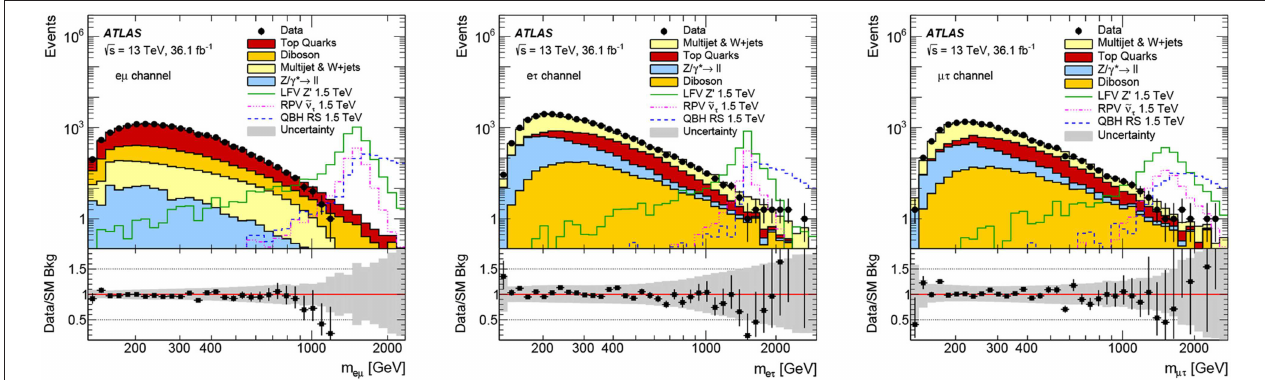
FIGURE 8 | The dilepton mass distributions of e µ without b -jet veto applied (left), e τ (middle), and µτ (right) pairs for data and SM predictions. The expected signal from Z ′ boson with a mass of 1.5TeV is overlaid. Also shown are signals expected by other models producing the same final states: τ -sneutrino and quantum black hole, both with masses of 1.5TeV. The error bars display the statistical uncertainty of the observed yields, the bands in the bottom panels include all statistical and systematic uncertainties combined in quadrature. No further data points are found in overflow bins. Reproduced from ATLAS Collaboration [63] under the Creative Commons CC-BY-4 license.